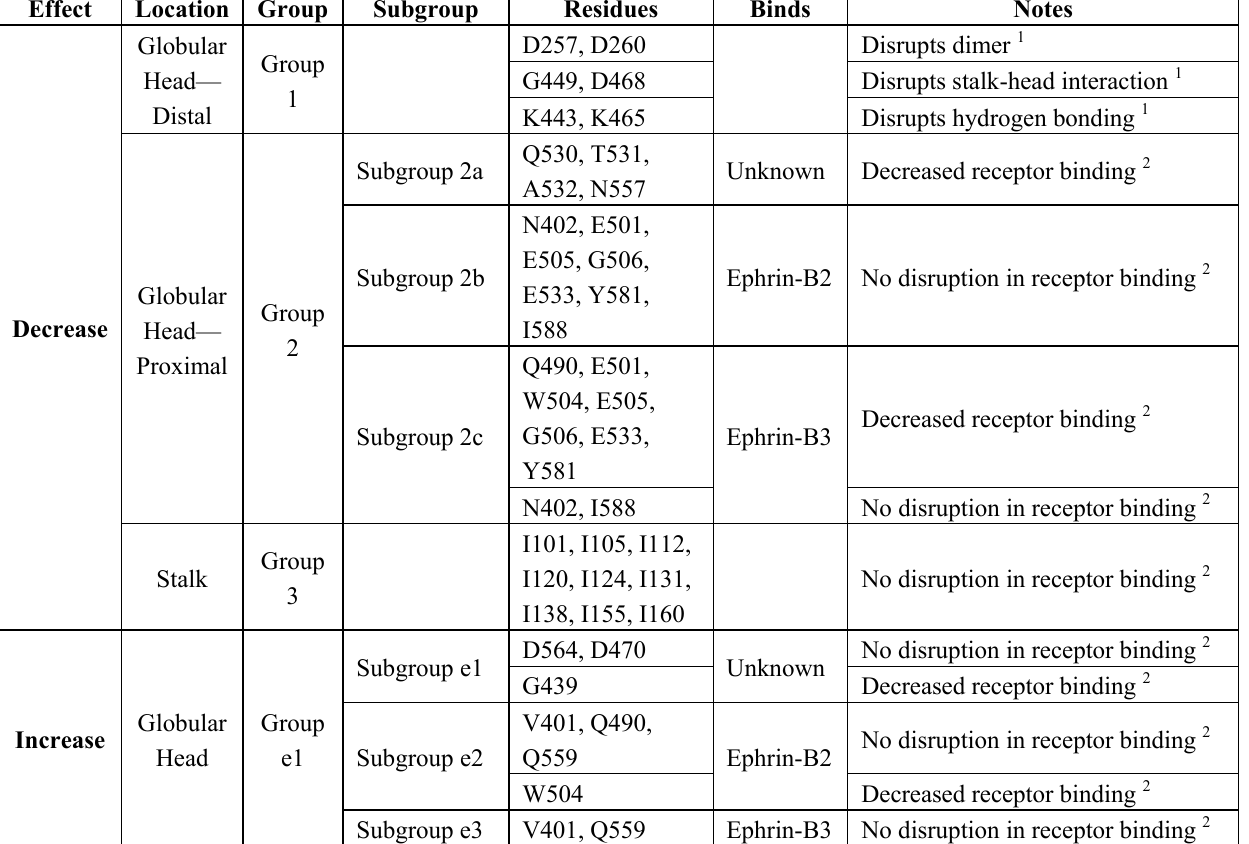
Table 2. Summary of HeV-G Mutants that affect fusion. Mutations that either decrease or increase HeV-mediated fusion are separated into various groups based on their location in the globular head (distal or proximal to ephrin-binding site) or stalk domain of HeV-G, which receptor is bound and whether the mutation affects receptor binding. Information supplied in the Notes column is based on the modeled structures of HeV-G head and stalk domains or obtained from experimental data as indicated. Squares shaded in gray represent information that is unknown or not